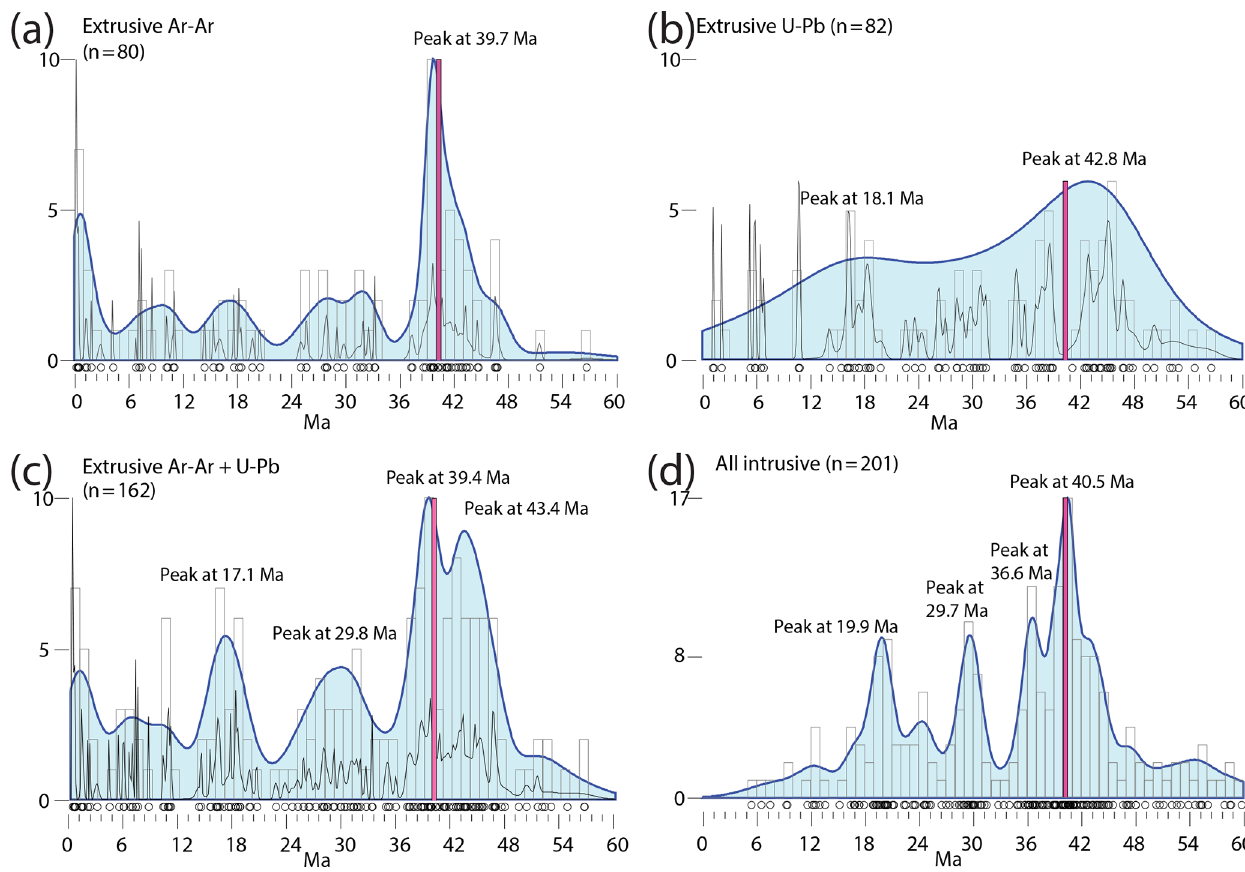
Figure 3. Radioisotope ages from 0–60Ma, compiled from the literature, combined with our newly obtained ages. Black thin line represents the probability density plot (PDP); blue filled line represents the kernel density estimate (KDE); boxes represent histograms (numbers on y axis). The timing and duration of the MECO is indicated by the pink box. (a) 40 Ar / 39 Ar ages from the literature combined with newly obtained ages for extrusive rocks only. (b) U − Pb ages from the literature for extrusive rocks only. (c) 40 Ar / 39 Ar data and U − Pb data from extrusive rocks only. (d) Combined ages from the literature for intrusive rocks